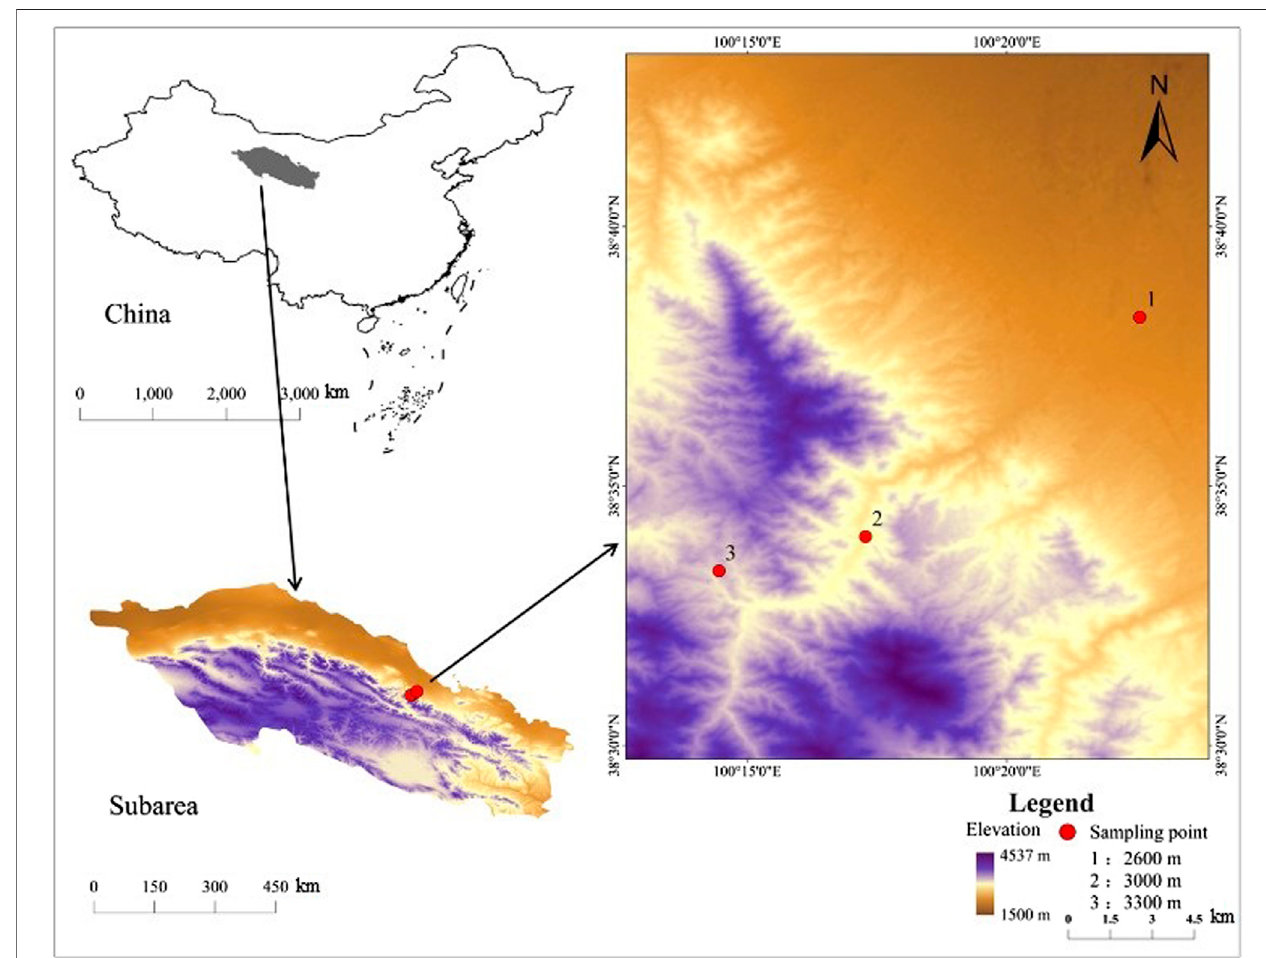
FIGURE 1 | Location of the sampling sites at 2,600, 3,000 and 3,300 m within the study area.